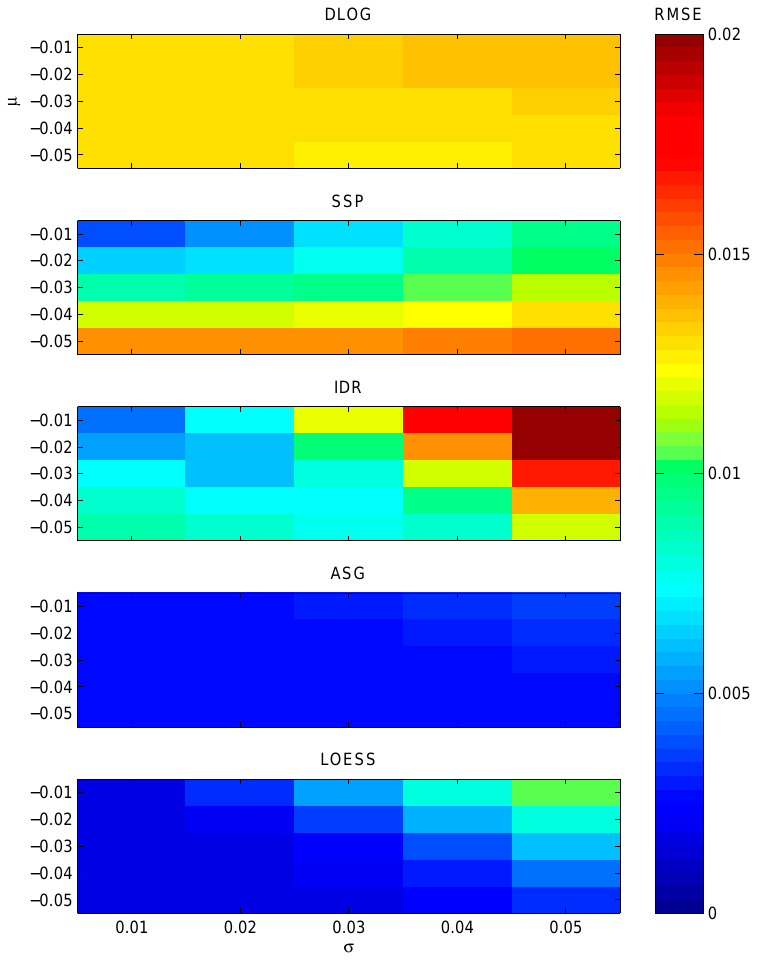
Figure 3. Comparison of the RMSE for the 25 N ( μ , σ ) simulations of the five filtering methods in a mixed forest